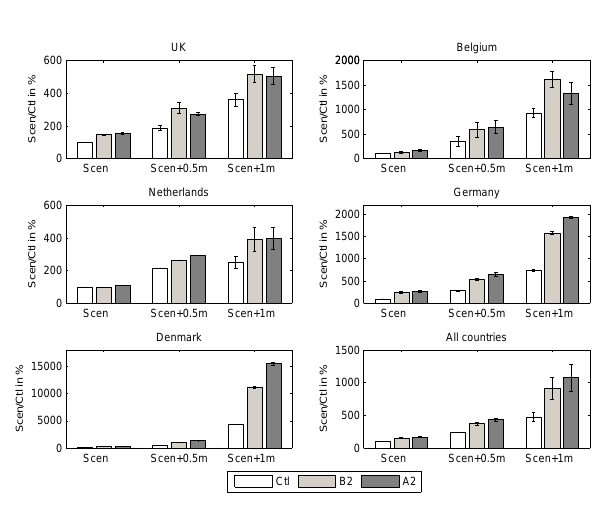
Fig. 8. Ratio of AEL for scenarios (Ctl, Ctl+SLR, A2, A2+SLR, B2, B2+SLR) with respect to present day conditions (control) in percent. Error bars represent uncertainty due to coastal protection parameter variation.